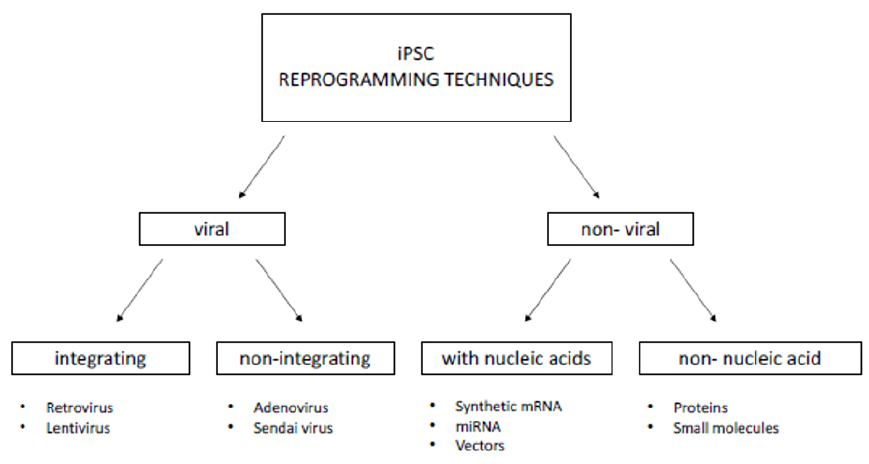
Figure 3. The most commonly used iPSC reprogramming